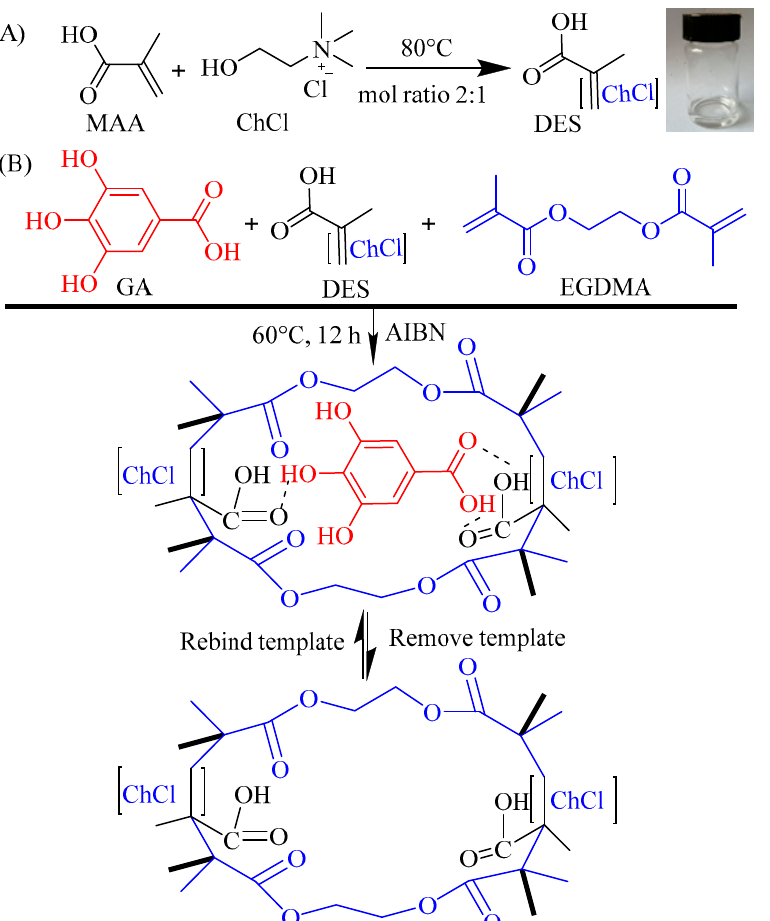
Figure 9. Schematic illustration of the procedure for preparing the DES with ChCl and MAA ( A ) and the DES@MIPswith DES as functional monomers ( B ).